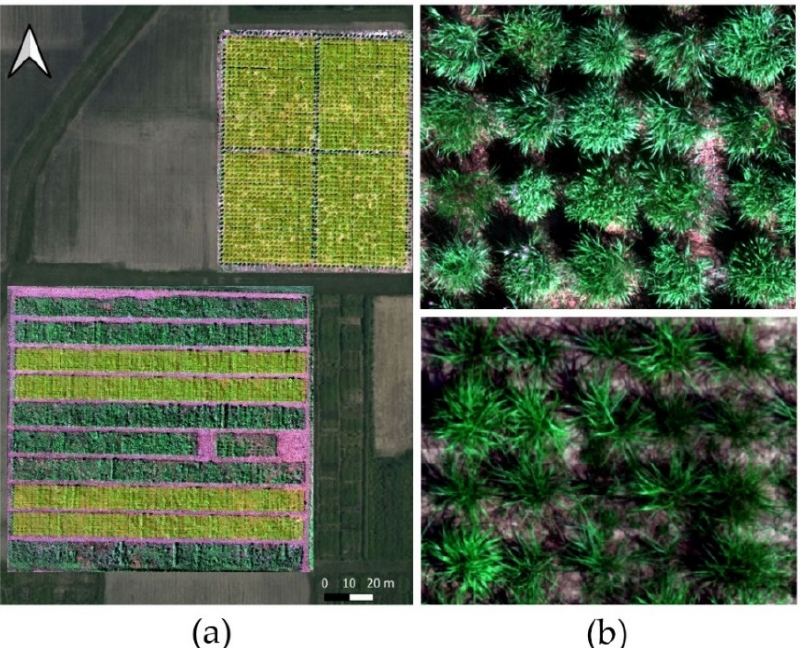
Figure 1. ( a ) Aerial overview of Miscanthus sacchariflorus (top) and Miscanthus sinensis (bottom) trials and plots analyzed in this study (in yellow) located at the Energy Farm, University of Illinois, Urbana. ( b ) Close-up images of plots and individual plants under intensive growth during the summer of 2020 (top, M. sacchariflorus ; bottom, M. sinensis ).